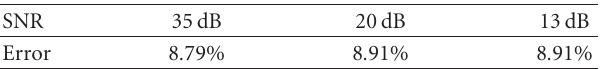
Figure 10: Risk versus cluster size when the speakers belonging to the largest cluster (cluster size is 18) were treated as an ensemble and clustered. Table 1: Misclassification errors at the optimal point for di ff erent SNRs when the number of speakers is 110.